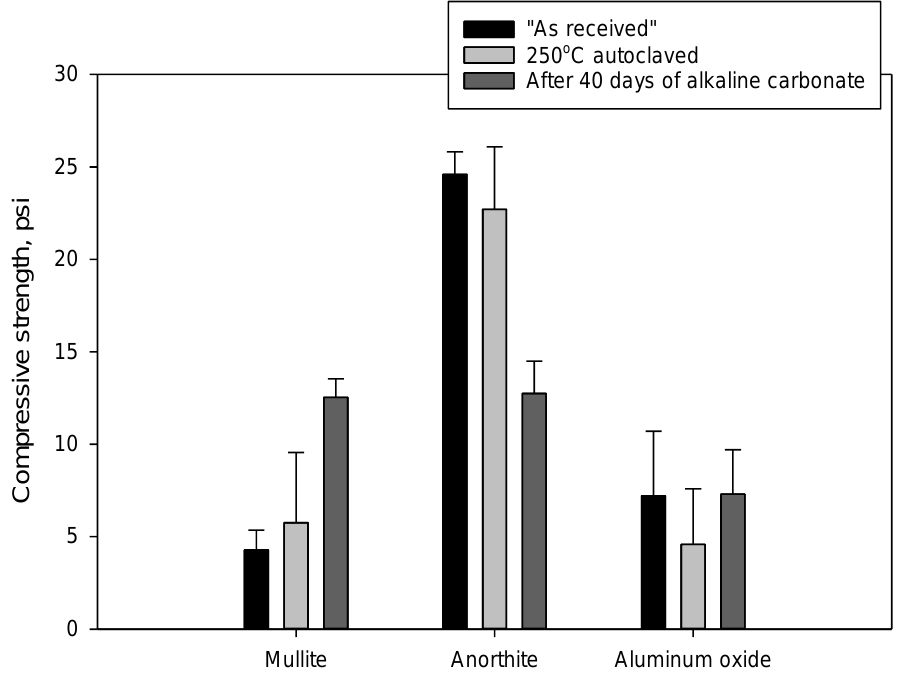
Figure 22. Compressive strength of “as received” (before exposure), 250 °C autoclaved and samples exposed to alkaline carbonate for 40 days at 250 °C.